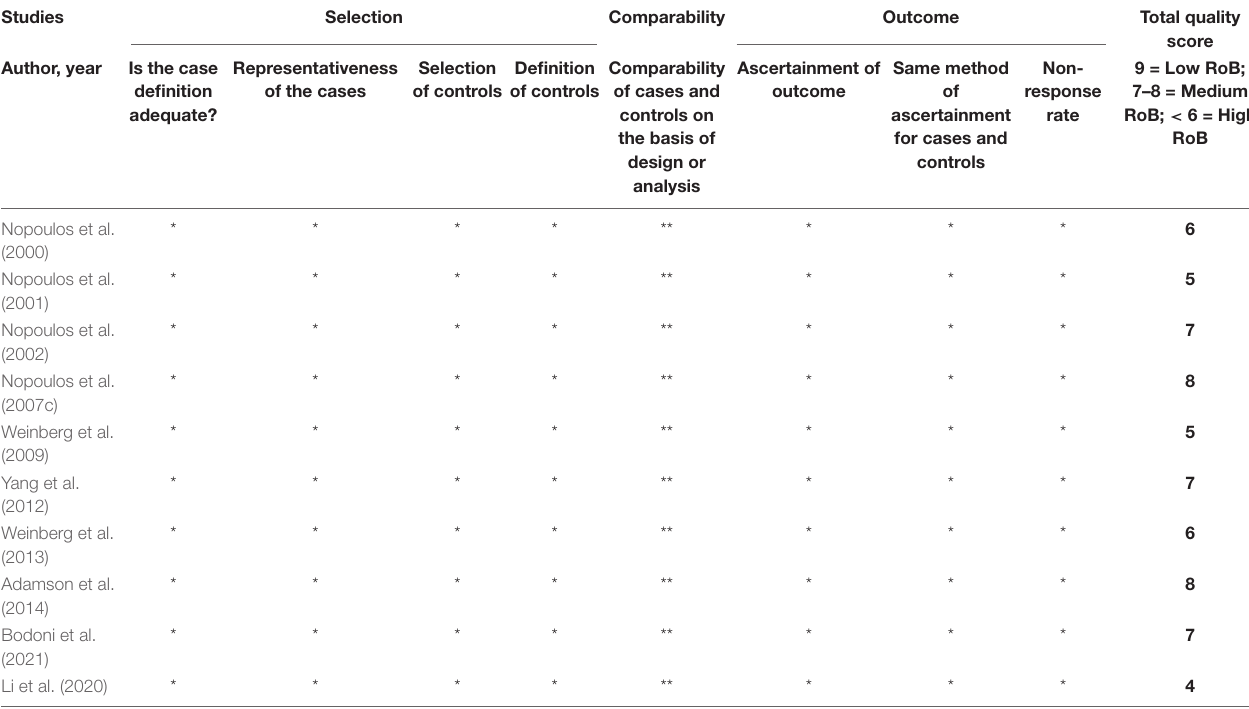
TABLE 2 | Risk of bias (RoB) assessment using the Newcastle-Ottawa Scale.